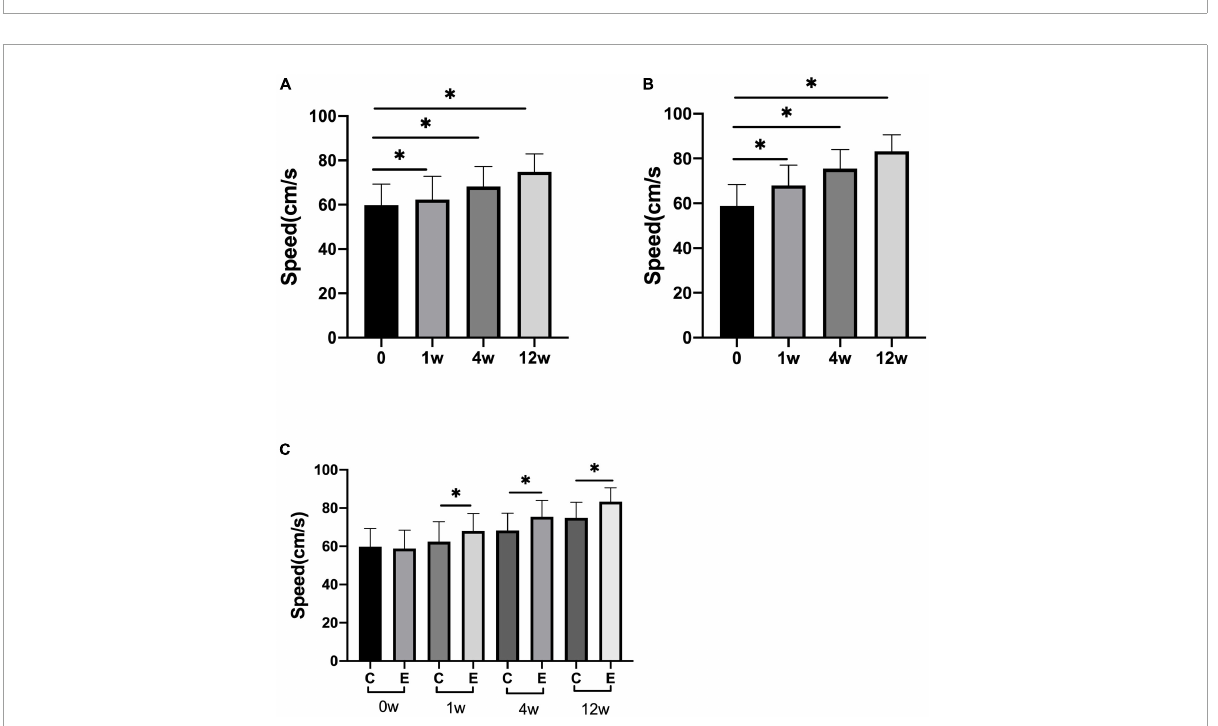
FIGURE6 Changes in speed of 10 meter walking test (10MWT) (cm/s). (A) The speed at 1, 4, and 12 weeks compared with that at 0 week in control group; (B) speed at 1, 4, and 12 weeks compared with that at 0 week in experimental group; (C) speed at 0, 1, 4, and 12 weeks in experimental group compared with control group; ∗ p <